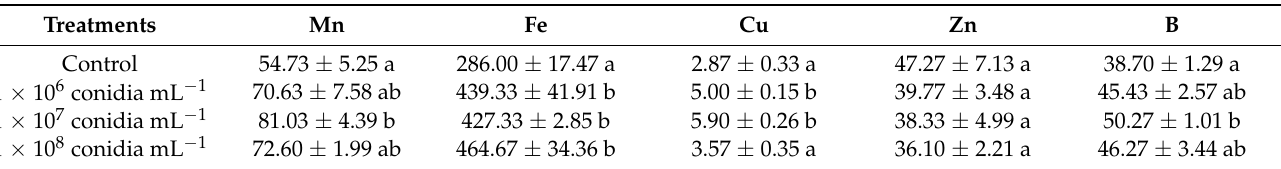
The means ± SE followed by the same lowercase letters column indicates means ± SE are not significantly different using Tukey HSD test at p = 0.05 level of